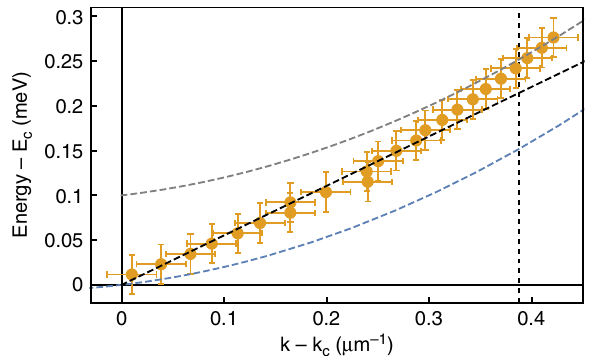
Fig. 4 Linearised dispersion relation. Experimental data of the excitation spectrum from Fig. 3d, zoomed in close to the condensate energy and momentum. The diagonal dashed-black line is the sound dispersion obtained from the same fi tting parameters as used in Fig. 3d. Parabolic dispersion relations associated with the condensate energy and the high- momentum part of the spectrum are reported for clarity using dashed blue and grey lines, respectively. The vertical dashed line is the cutoff wavevector 1 ξ above which the dispersion is almost